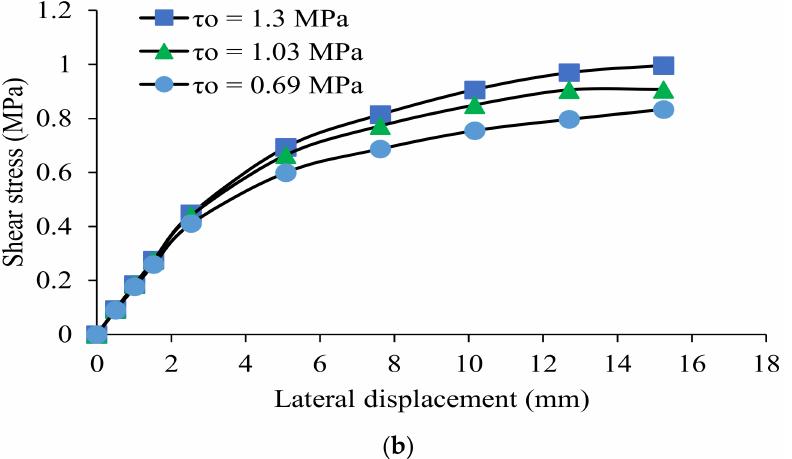
Figure 13. Influence of contact properties on shear strength of URM walls: ( a ) friction, ( b )